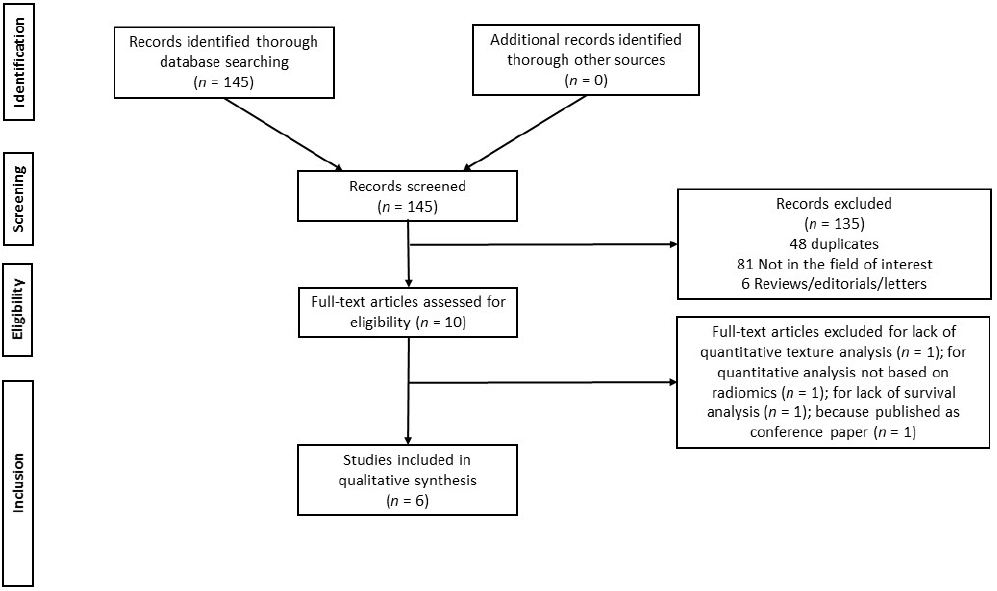
Figure 1. Study Selection Flowchart.